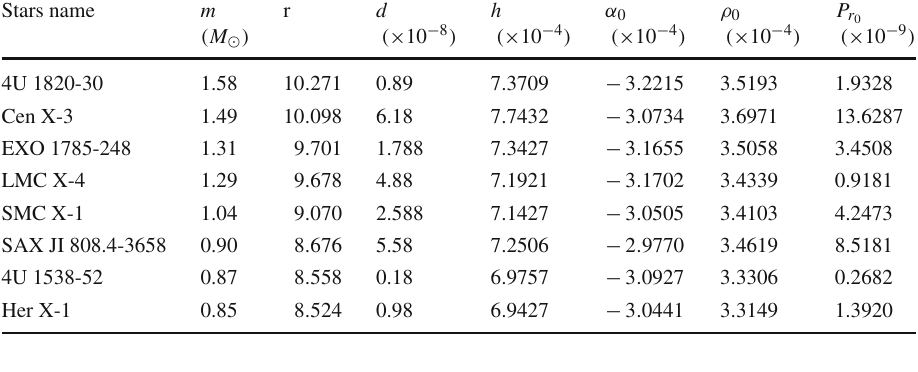
Table 2 Variation of radiation density, radial pressure, electric field intensity and mass from center to boundary of realistic star EXO